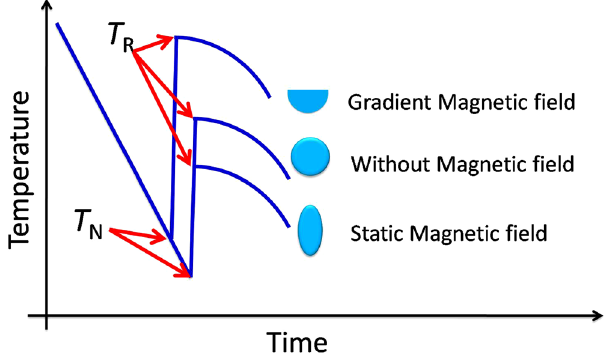
Figure 5. Schematic figure showing the recalescence and sample shape solidified under different conditions.